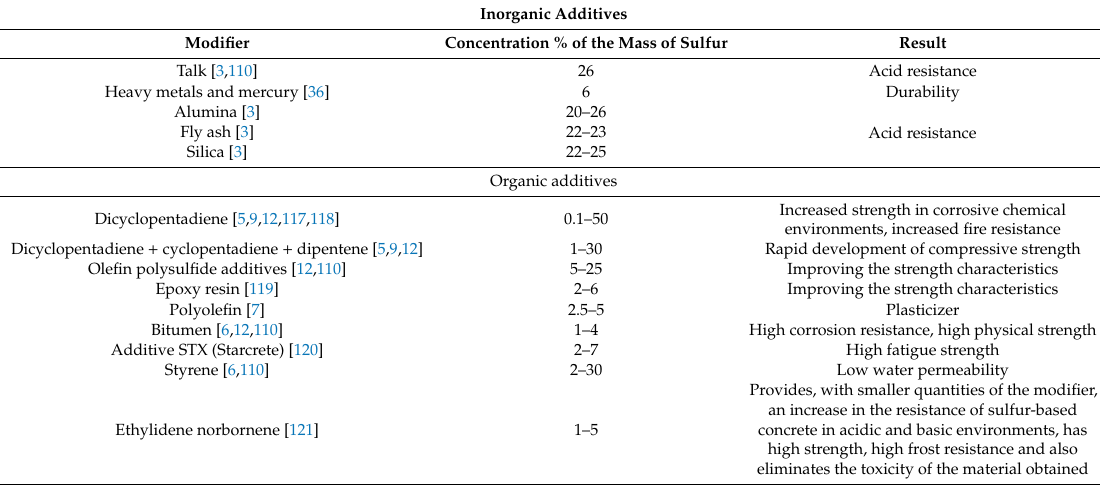
Table 5. Modifiers and fillers for sulfur-based